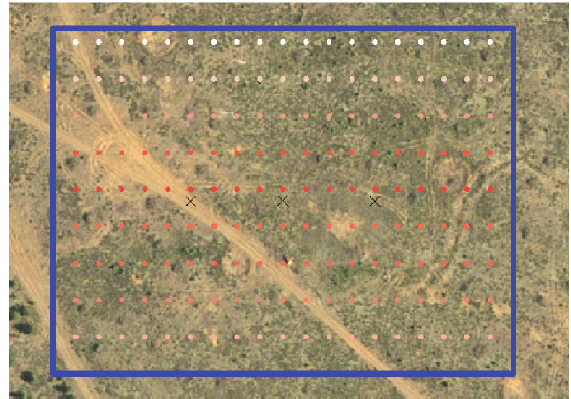
Fig. 7. The area covered by enemy